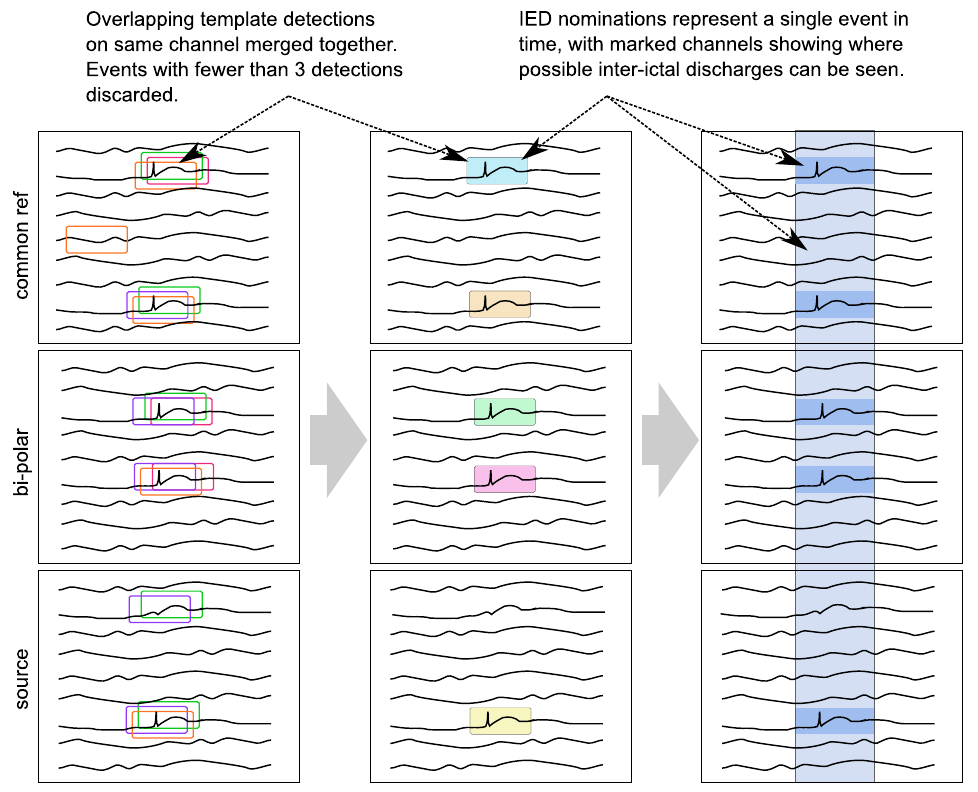
Figure 3. Grouping and merging of template detections. Overlapping templates are merged together and grouped to form single IED nominations, which are presented to the reviewer as a single event in time. Channels containing template detections are highlighted to point out where inter-ictal activity was found.